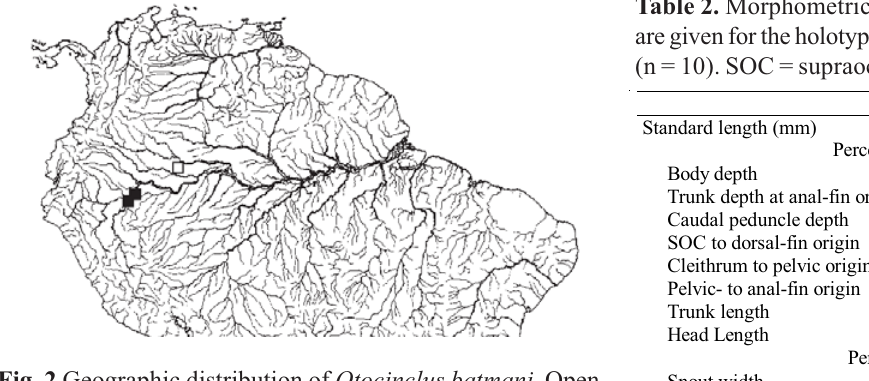
Fig. 2 Geographic distribution of Otocinclus batmani . Open symbol is type locality.